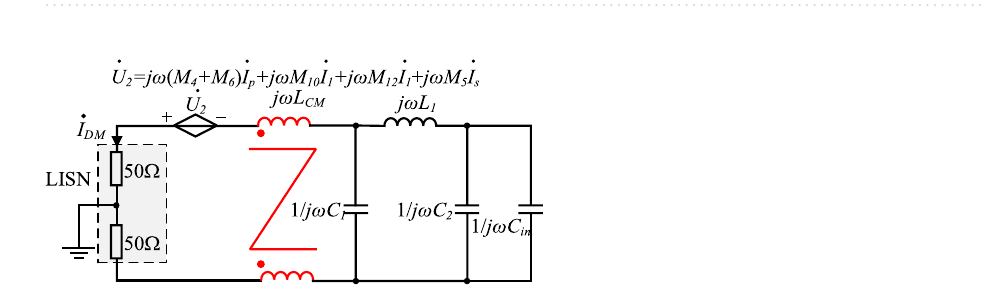
Figure 7. DM noise equivalent circuit diagram considering the effects of near-field coupling on DM choke.